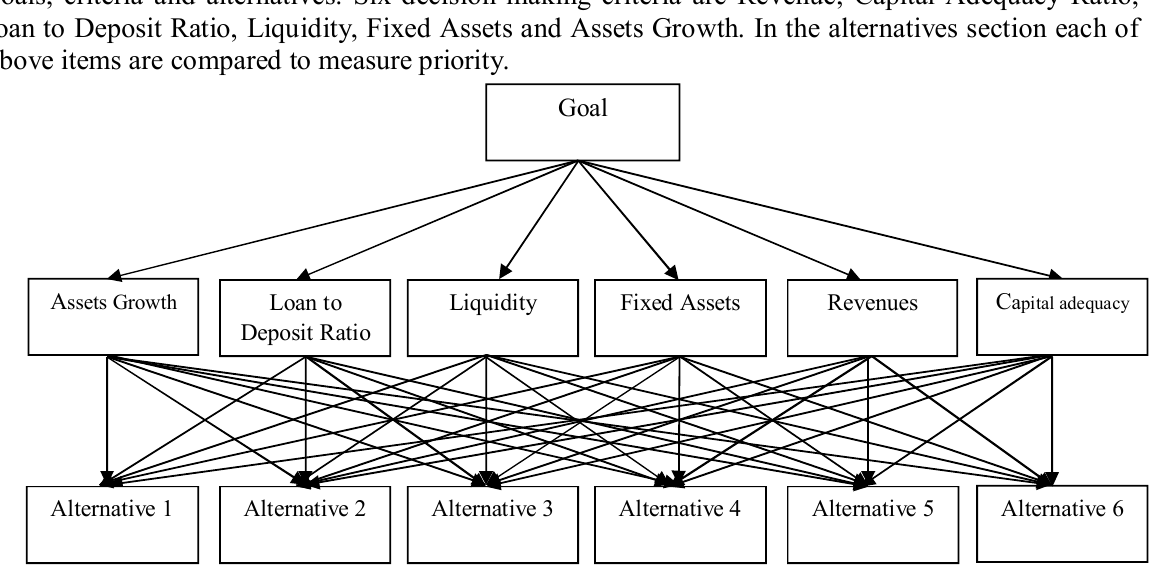
Fig. 1. Structure of Analytical Hierarchy Process Model in This